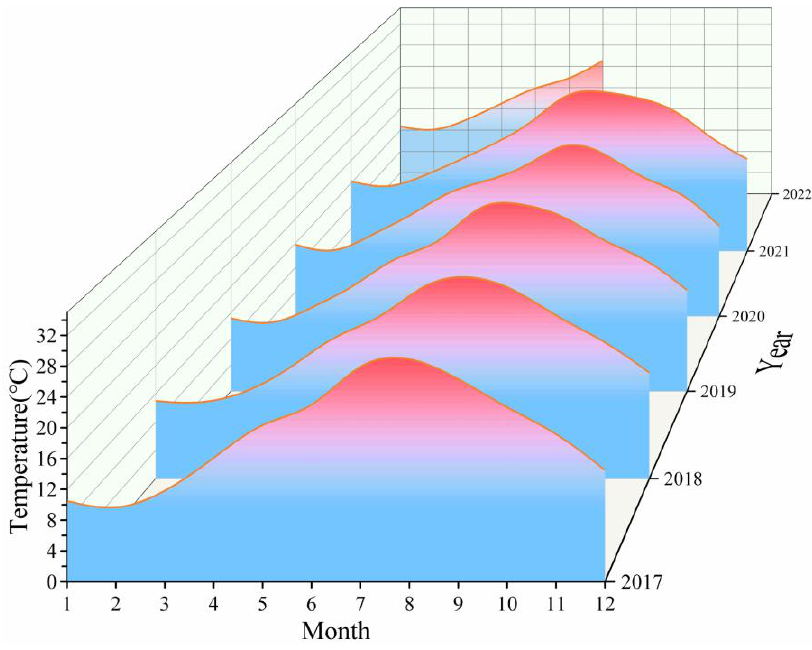
Figure 3. Variation of SST at Gouqi Island from 2017 to 2022.